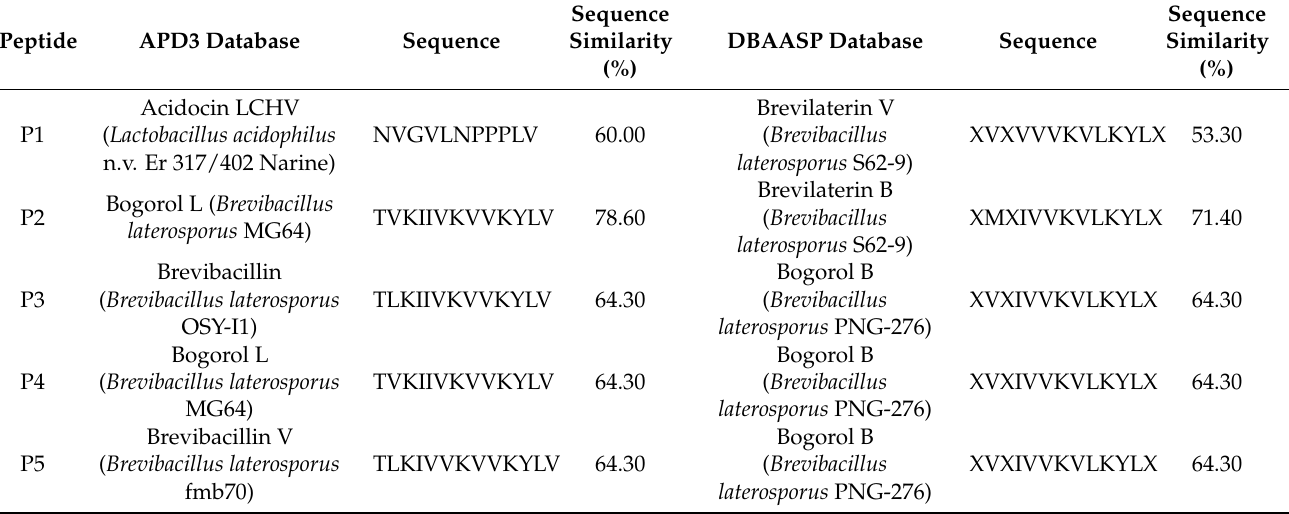
Table 7. Sequence comparison between P1–P5 and AMPs from APD3 and DBAASP databases. The similarity was determined by MatGAT